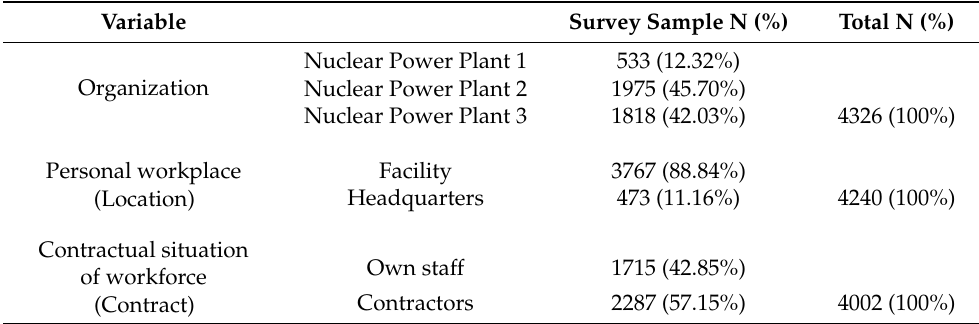
Table 1. Study survey sample and